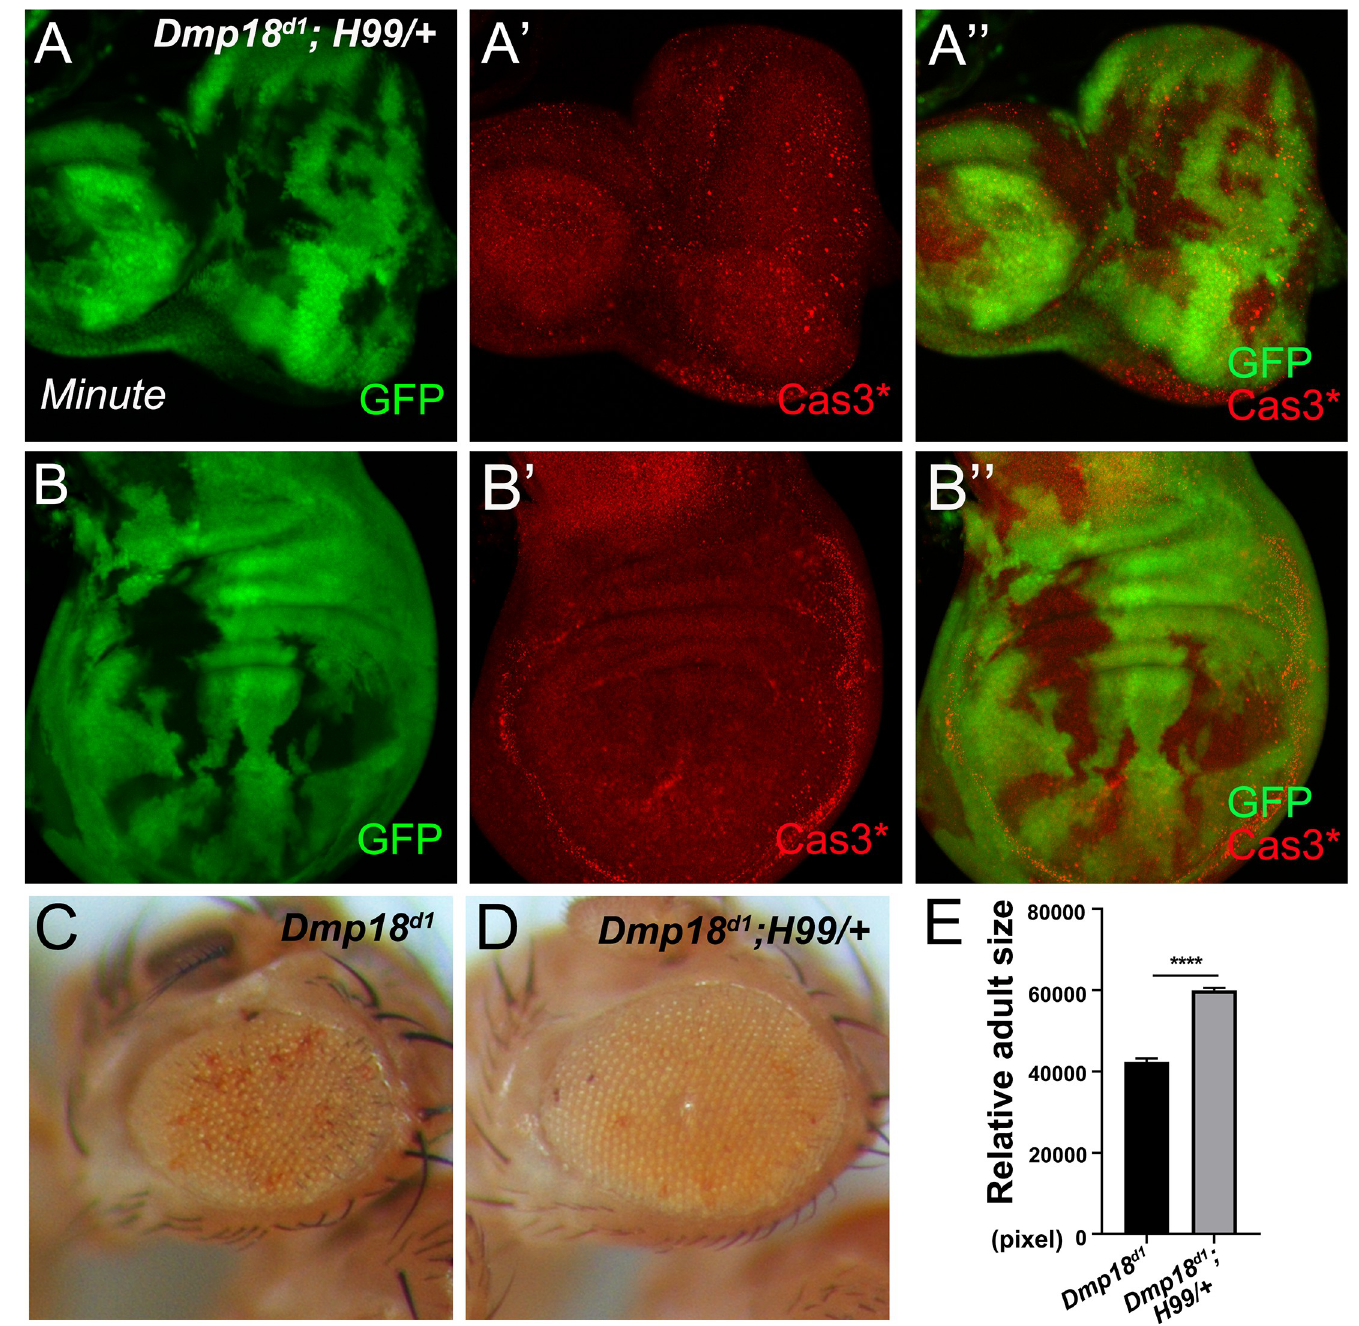
Fig 3. H99 inhibits Dmp18 deletion-induced apoptosis. (A-B”) H99 inhibited the Cas3 � activity in the Dmp18 mutant clones both in the eye and wing discs. GFP-free region marked the Dmp18 mutant clones. (C-D) H99 dramatically restored the small eye defect induced by Dmp18 deletion. Adult eye phenotypes were generated by EGUF/hid method. (E) Statistical analysis of the relative adult eye size of C and D. ���� p < 0.0001, the number of C = 34 and the number of D = 34. Genotypes: A-B”: yw , hs-FLP/+; FRT 40A -M(2L)-Ubi-GFP/FRT 40A -Dmp18 d1 ; H99/+ . C: yw , ey-Gal4 , UAS-FLP/X; FRT 40A , GMR-hid/FRT 40A -Dmp18 d1 ; UAS-CD8-GFP/+ ; D: yw , ey-Gal4 , UAS-FLP/X; FRT 40A , GMR-hid/FRT 40A -Dmp18 d1 ; UAS-CD8-GFP/H99 .